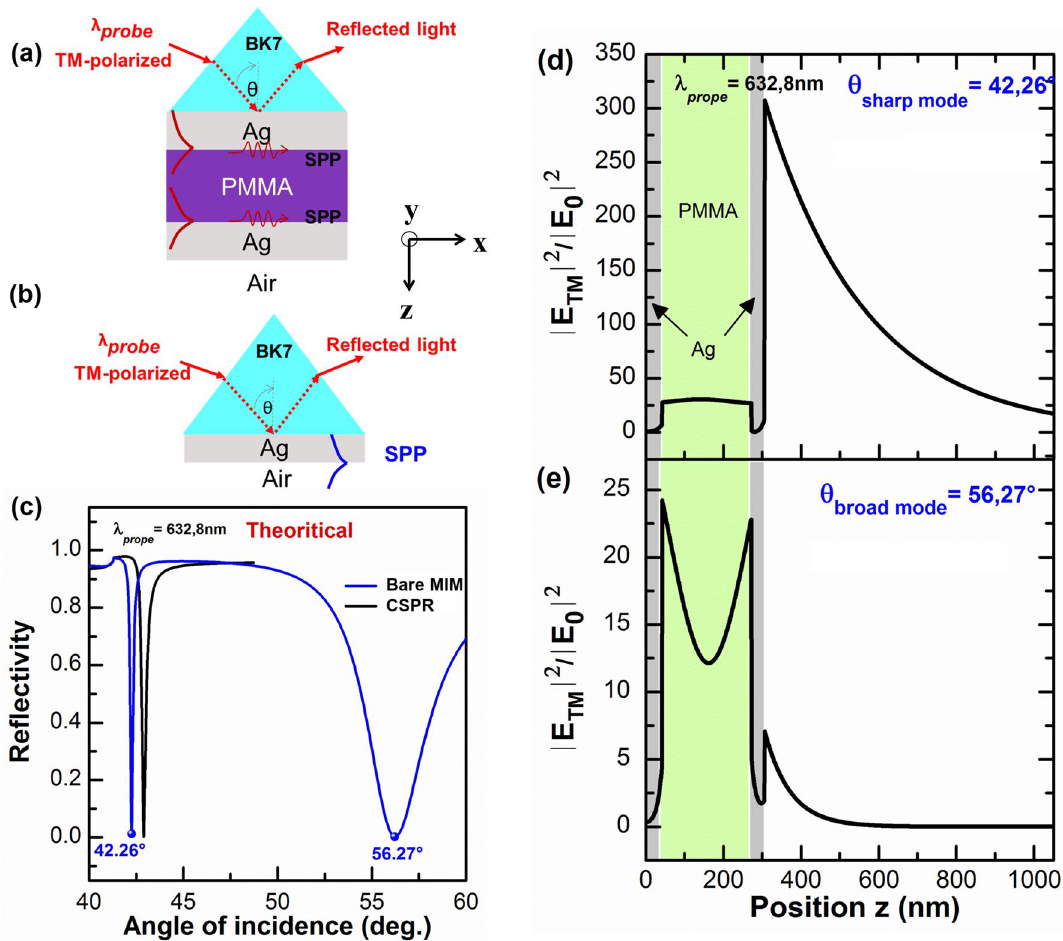
Figure 1. Calculations of θ -scan ATR and electric field profiles. Schematic configuration of ( a ) the MIM stack consisting of PMMA sandwiched between 2 Ag layers, and ( b ) the CSPR sensor based on silver. The outer medium in both structures is air. and x , y , and z correspond to the system coordinates ( c ) θ -scan ATR calculations of MIM and CSPR structures without the sensing layer (SL); and ( d , e ) Electric field profiles of the MIM structure calculated at the sharp and broad modes resonance angles, i.e. at 42.26° and 56.27°; of the different materials used in our structures are identical to those reported in 10 (vide infra). The results of the calculations are shown in Fig. 1c–e. Figure 1c is the θ -scan of the ATR spectra obtained for the MIM and CSPR sensors without the SL. Note that the MIM structure exhibits a sharp ATR mode around 42.26° and a broad mode around 56.27°. The purpose of this section of the study is to discuss the nature of the modes of the MIM structure and to show that the sharp mode is appropriate for thin film sensing, and compare the characteristics of the sharp mode to those of the CSPR mode. Indeed, the sharp mode is located at an angle lower than that of CSPR, and the full width at half maximum (FWHM) of the CSPR mode is two times larger than that of the MIM sharp mode. According to our previous study 12,47 , a MIM structure with a semi-infinite metal bears both symmetric (S-SPP), and antisymmetric (AS- SPP) modes that arise from the coupling of the two SPP modes localized at MI interfaces of the MIM structure (Fig. 1a), assuming that the insulator layer is thin enough. When the metal layers have finite thicknesses, the MIM structure sustains also an SPP mode localized at the outer Ag/Air, interface 12,47 . S-SPP and SPP couple to each other through their evanescent fields inside the Ag layer, and lead to hybrid modes; i.e. a sharp and a broad modes. We performed EM calculations of the EF distributions of our MIM structures by the 2 × 2 transfer matrix method 48 . The square of the amplitude of the electric field normalized to that of the incident light (cid:31) | E TM | 2 / | E 0 | 2 (cid:30) is plotted as a function of the position z of the bare MIM structure (Fig. 1d,e) at the incident angles 42.26° and 56.27° corresponding to the sharp and the broad resonances dips; respectively (Fig. 1c). Figure 1d,e as well as electric field profiles shown in Supporting Information, show that the MIM modes are hybrid in nature indeed. The electric field of the sharp dip is highly enhanced at the Ag/air interface and decays exponentially in air away from the interface. Judging from the electric field profile, the sharp mode is basically a SPP mode localized at the Ag/air interface, referred hereto by Ag/Air-SPP mode. The electric field profile of the broad dip (Fig. 1e) consists of an amplitude inside the PMMA layer larger than the weak exponential tail in air, and the profile inside the PMMA layer is typical of the S-SPP. The light energy inside and outside the PMMA layer is weaker for the